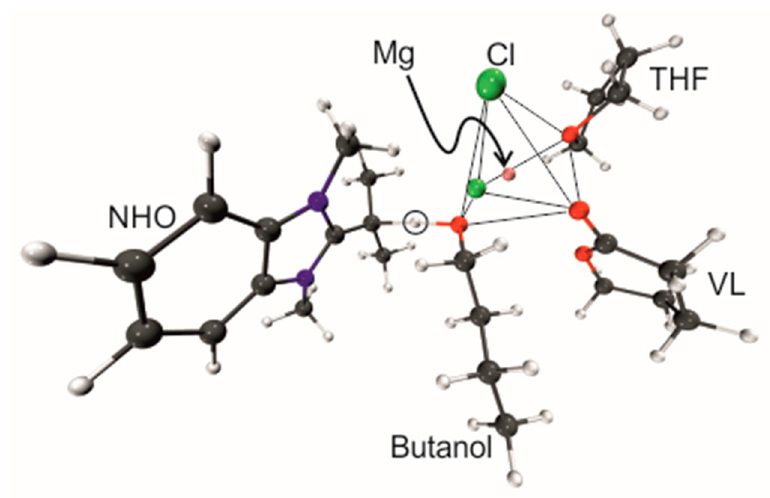
Figure 3. Transition structure of the proton transfer. The lines indicate the trigonal-bipyramidal coordination polyhedron. Encircled: Transferred proton.